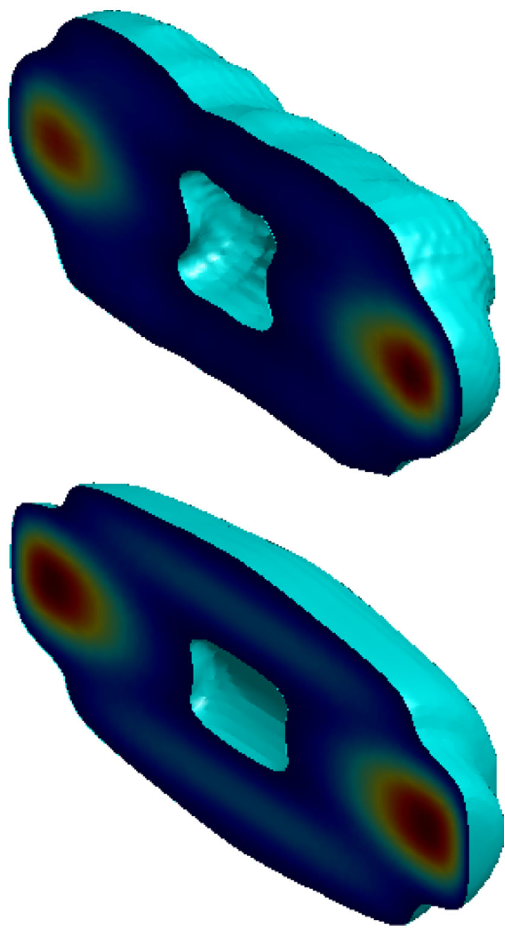
FIG. 12. (Color) Cut-away view along the t - r plane of the measured (upper) and calculated (lower) spatiotemporal isoin- tensity surface plot of the P ¼ 3 mm case in Fig.